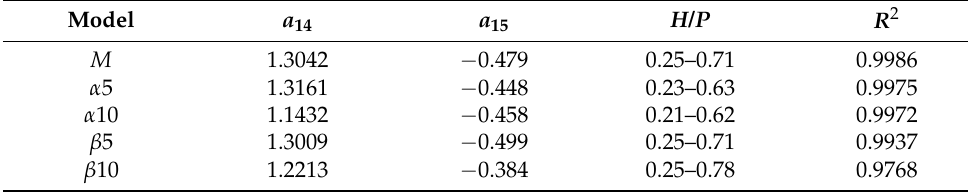
Table 6. The coefficients of equation (22) for the various